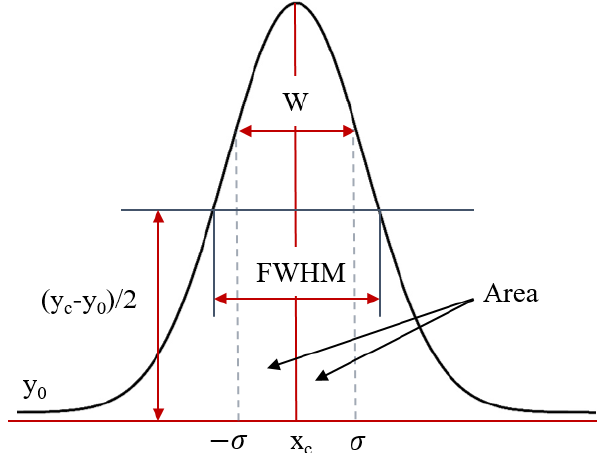
Figure 3. Algorithm of Gaussian distribution for envelope energy.